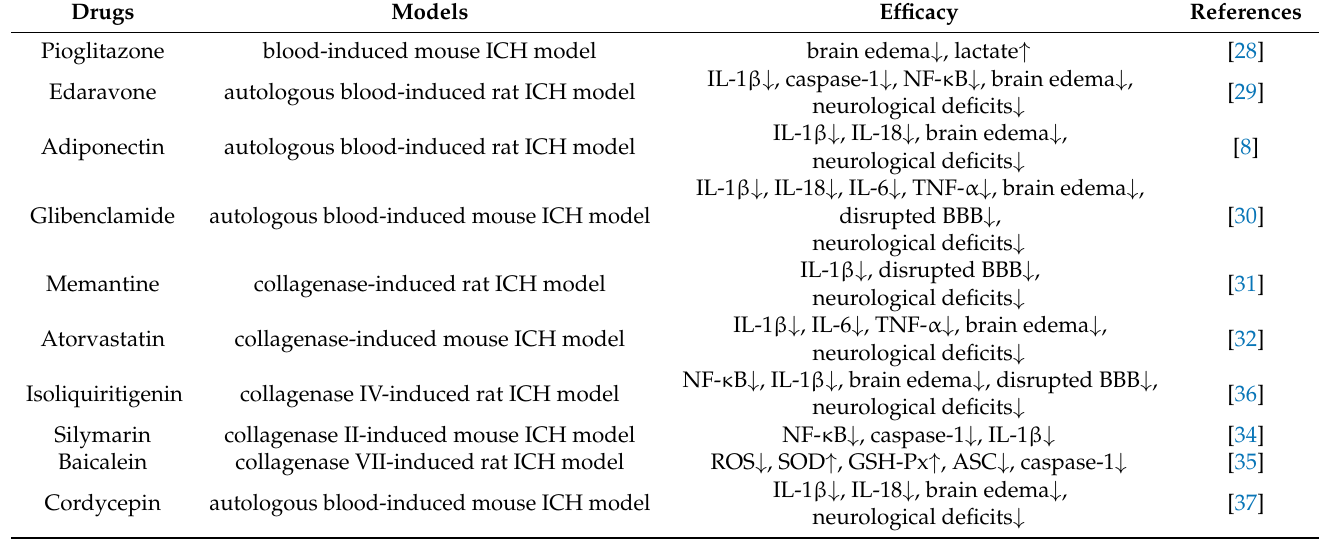
Table 1. Potential NLRP3 inflammasome inhibitors for protecting against SBI after